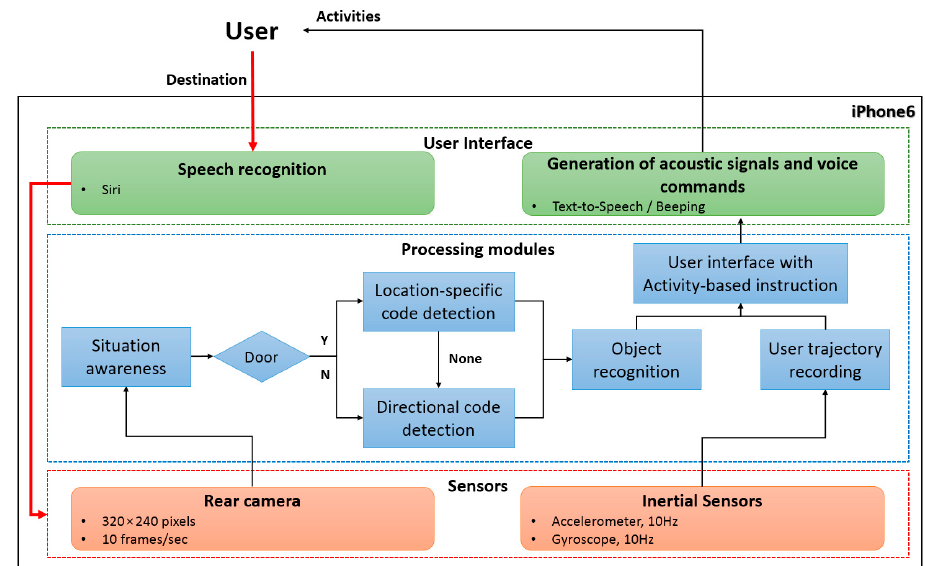
Figure 3. Overall architecture of the proposed wayfinding system.